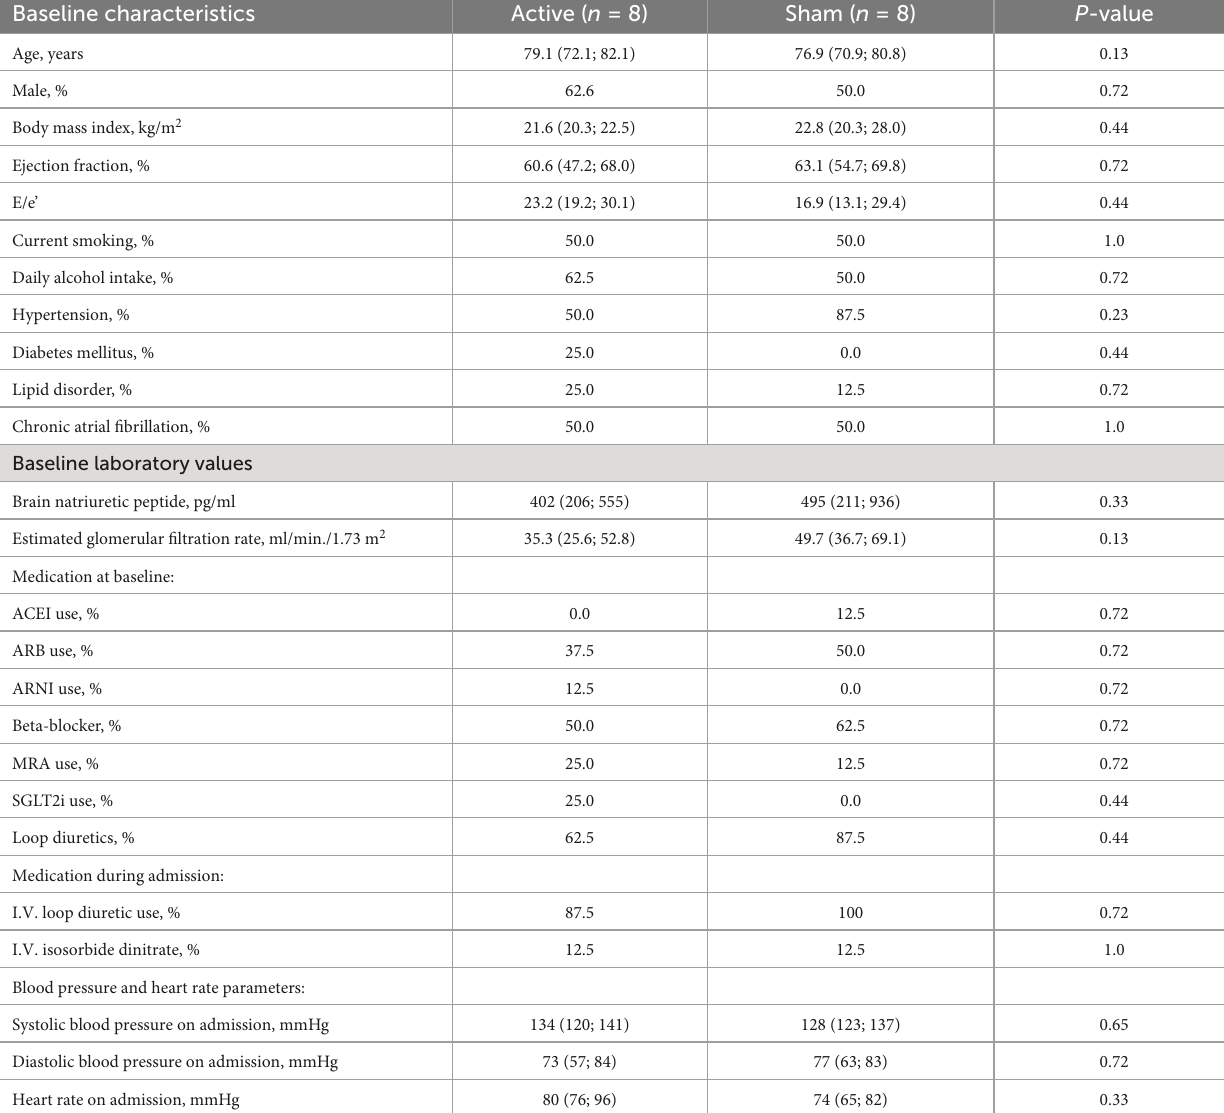
TABLE 1 Baseline characteristics of the study population. Baseline